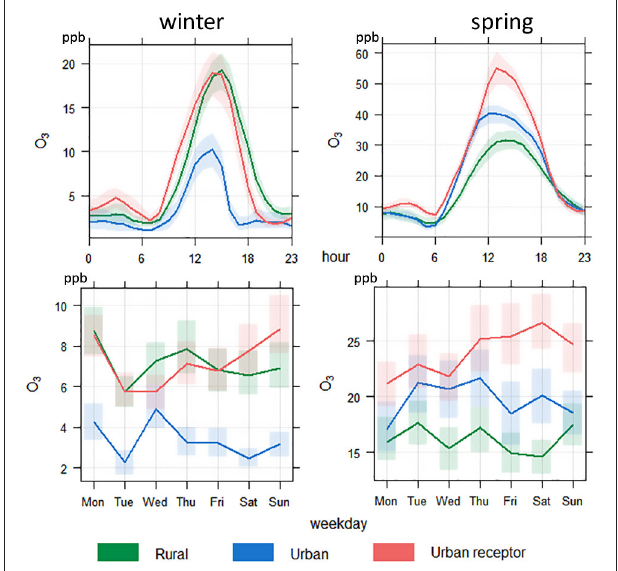
FIGURE 3 | Diurnal and weekly variation of 1-h average O 3 concentration (ppb) during winter and spring campaigns. Mean (solid line) and 95% confidence intervals in the mean (darkened area/shadow bars around mean) indicated in